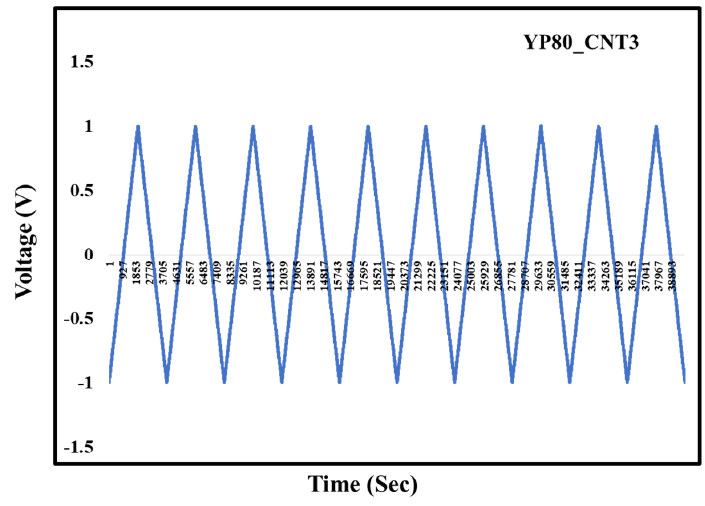
Figure 7. The changes in charge–discharge caused by time and voltage